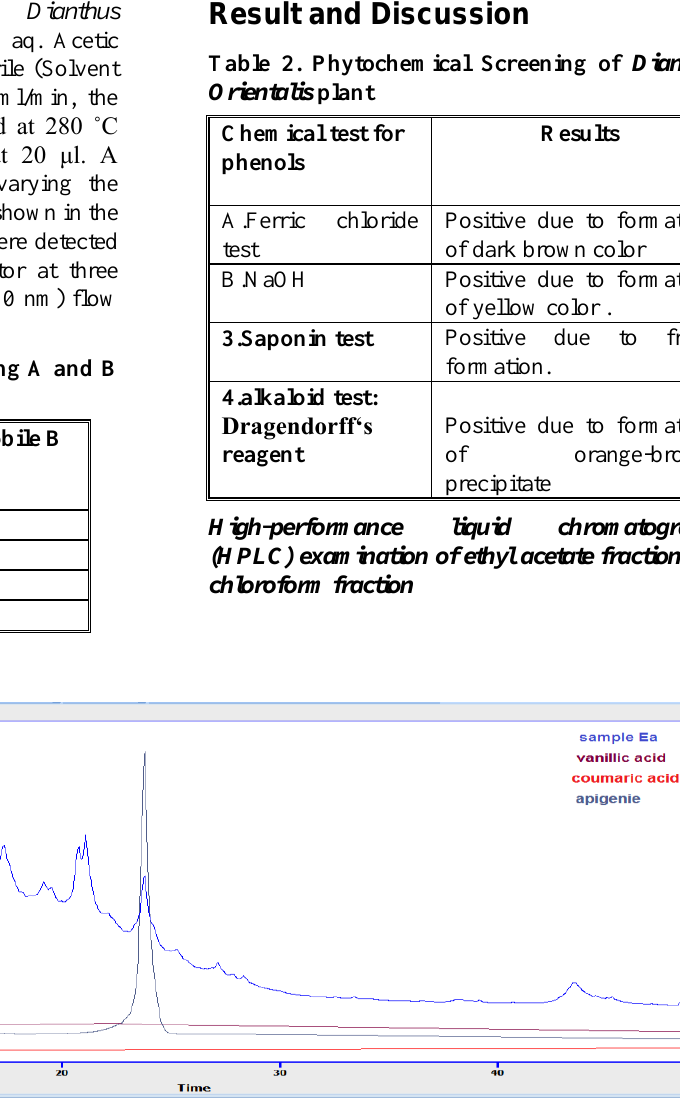
Figure 1. HPLC chromatogram for ethyl acetate